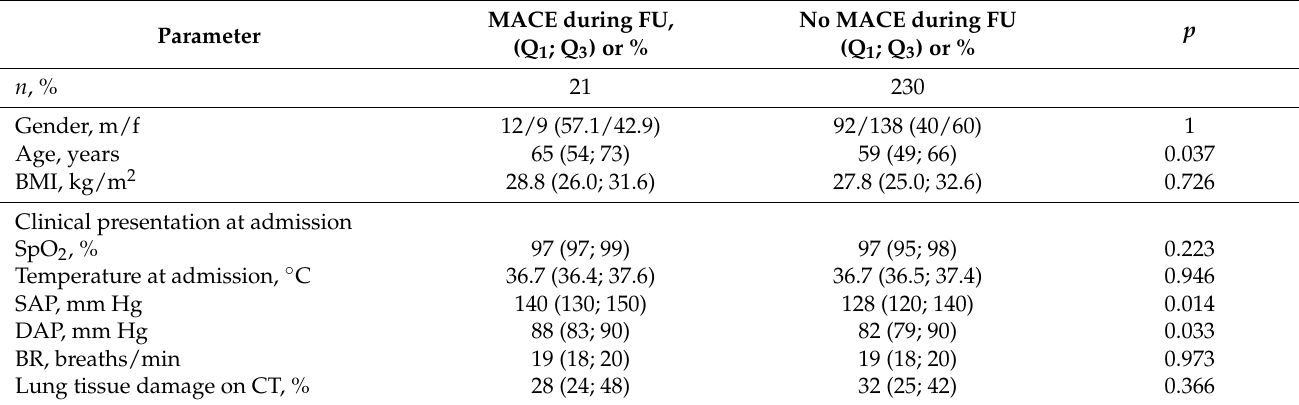
Table 3. Comparison of MACE vs. no MACE during follow-up after hospital discharge in COVID-19 survivors. MACE during Parameter